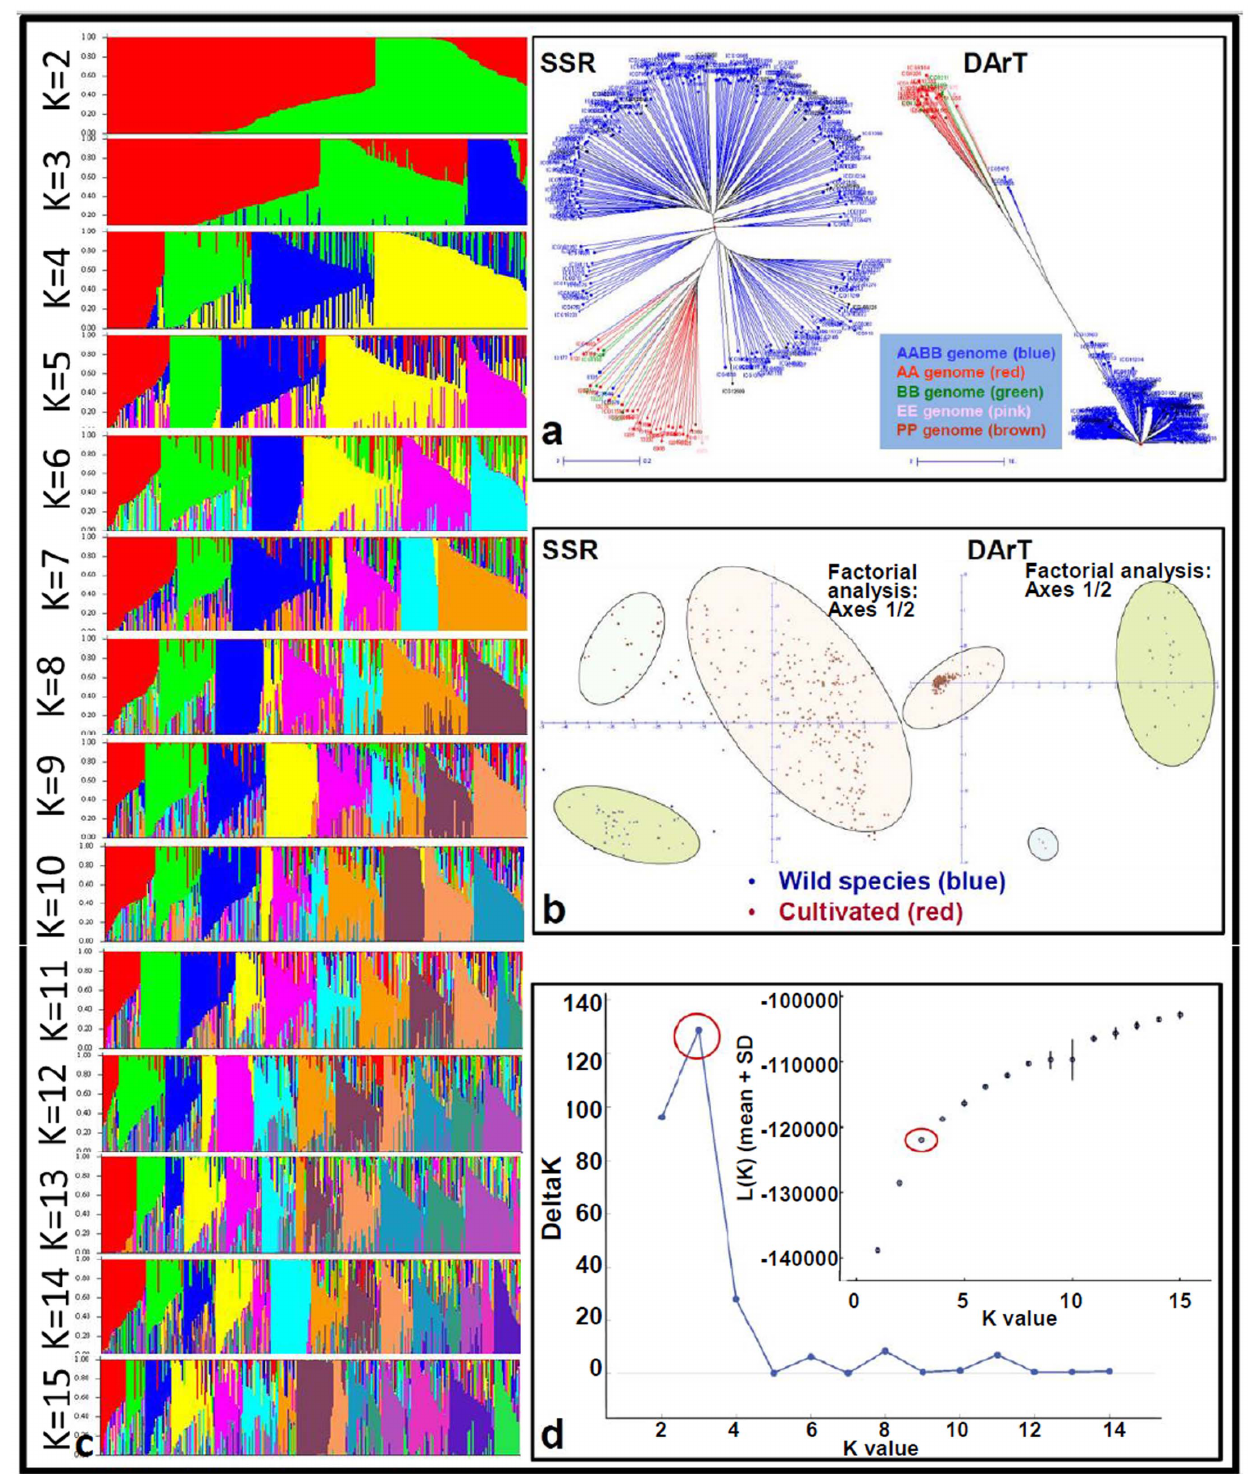
Figure 1. Genetic and population structure of the peanut ‘reference set’. This figure shows (a) grouping of genotypes based on SSR and DArT marker genotyping data, (b) principle co-ordinate analysis (PCoA) based on SSR and DArT marker genotyping data. In the case of SSR as well as DArT based PCoA, cultivated genotypes are clustered in two groups and the wild species genotypes are clustered in one group. (c) the population structure in the reference set at different values of K (K=1 to K=15), and (d) presence of three subgroups based on mean Fst values.